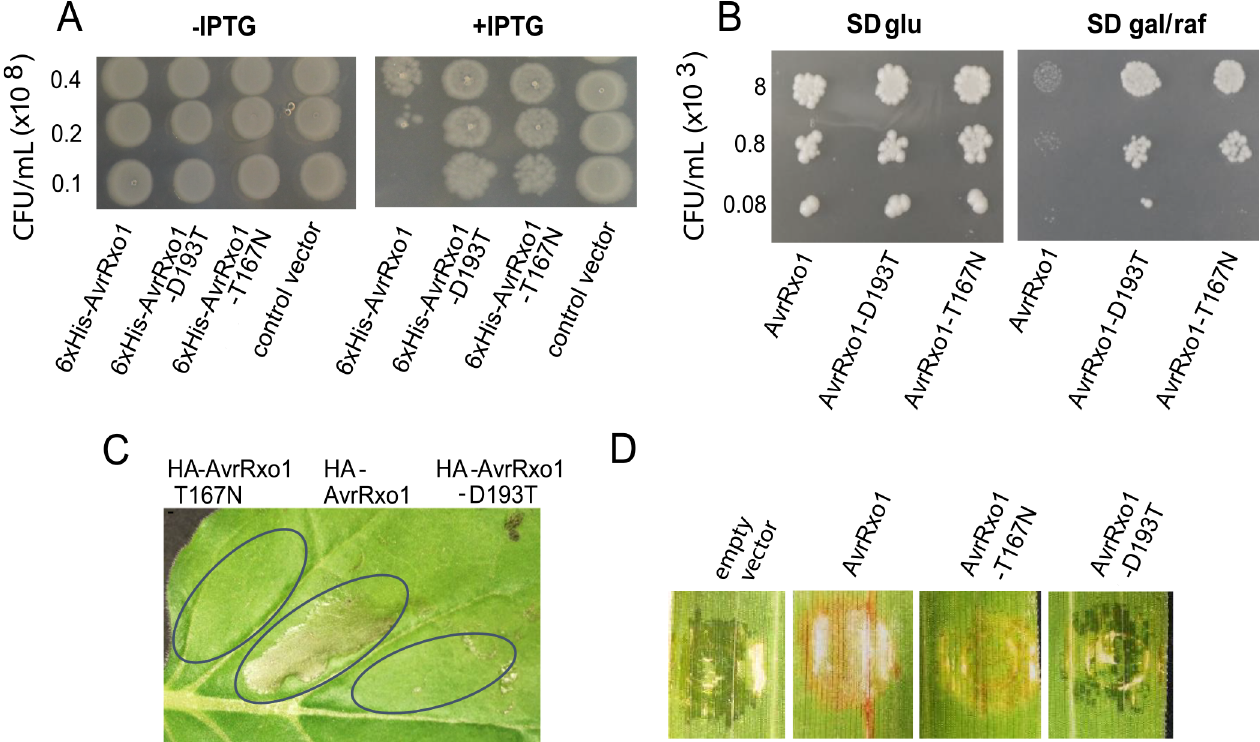
Fig 1. Requirement of predicted catalytic residues of AvrRxo1for toxic or growth-suppressive effects in prokaryotes and eukaryotes and for induction of HR in Rxo1 rice. (A) E . coli transformed with pDEST-AvrRxo1, pDEST-AvrRxo1-D193T, pDEST-AvrRxo1-T167N, and pDESTcv grown on (-IPTG) and inducing(+IPTG) media. (B) S . cerevisiae transformed with pESC-Trp-DEST-AvrRxo1 and catalytic site mutant derivatives pESC-Trp-DEST-D193T and -T167N on repressing(SD media amendedwith 2% glucose) and inducing(SD media amendedwith 2%/ 1% galactose/raffinose) media. (C) N . benthamiana leaf duringtransient Agrobacterium -mediated expressionof HA-AvrRxo1, HA-AvrRxo1-D193T and HA-AvrRxo1-T167N. Leaf was imaged 50 hours after infiltration.Expression analysisshown in S1 Fig. (D) Leaves of transgenicrice variety Kitaake expressingRxo1 were inoculated with derivatives of X . oryzae strain X11-5A carryingpHM1-AvrRxo1, pHM1-AvrRxo1-D193T, pHM1-AvrRxo1-T167N,or the empty vector pHM1. Appearance of water-soaking lesionsor HR were recorded5 days post infiltration.